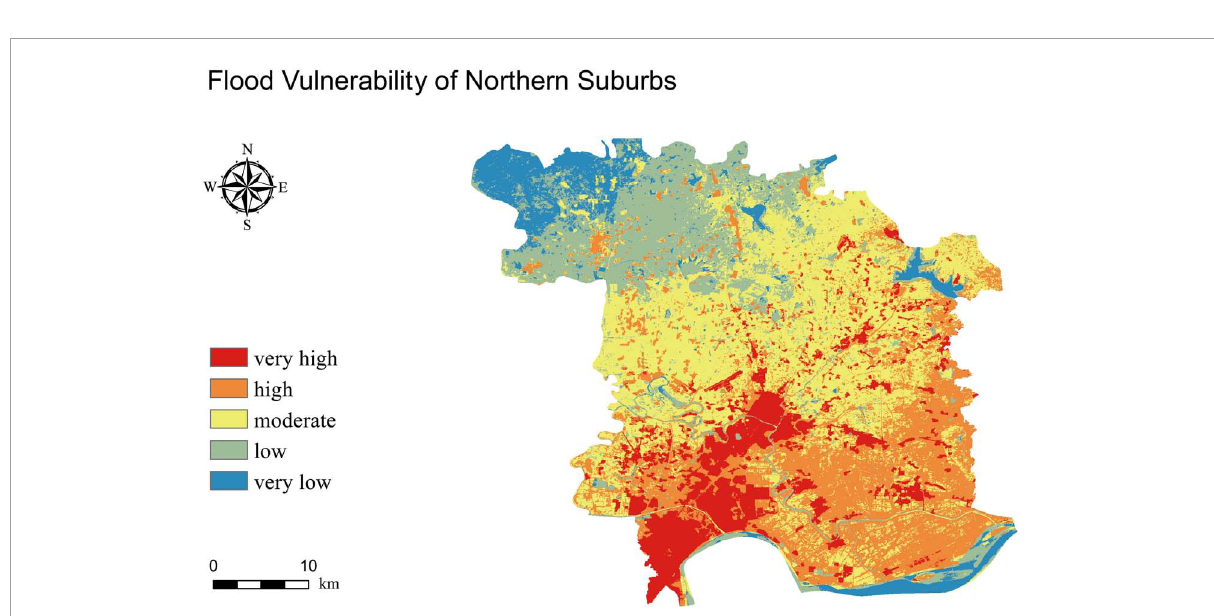
FIGURE7 The flood vulnerability levels of northern